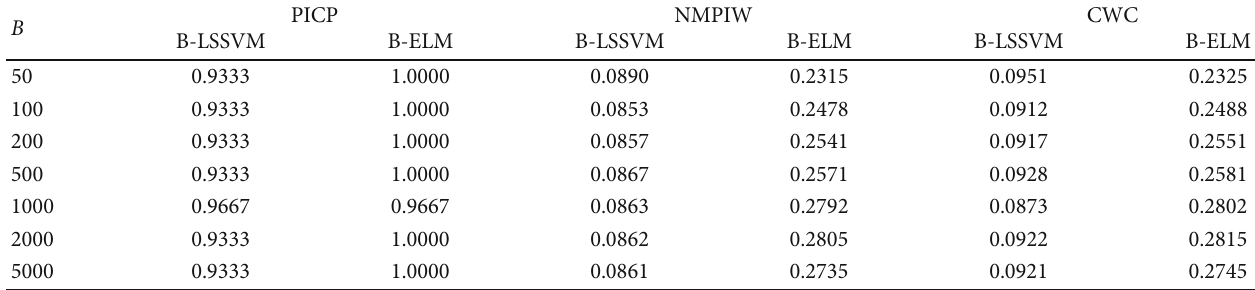
Table 3: PI performance index of ZG289.